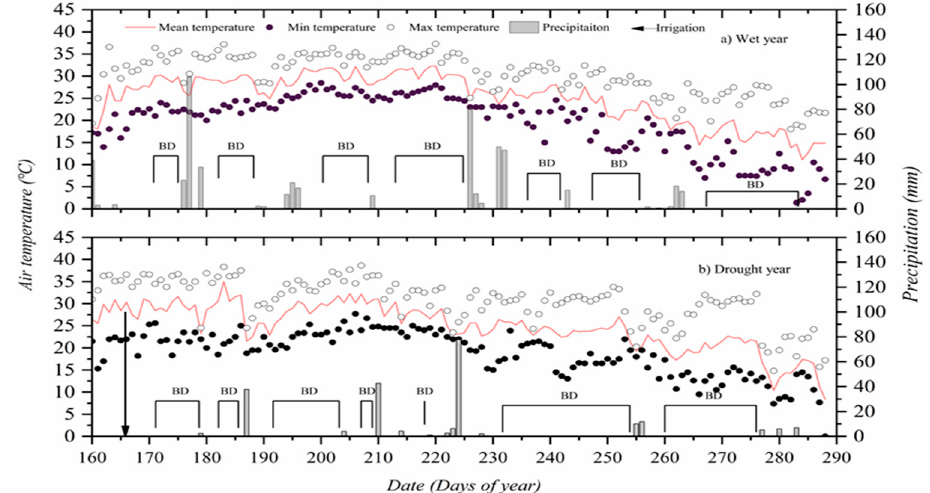
Figure 1. Mean, minimum, and maximum air temperature (°C) and precipitation (mm) during the maize growth stage (day 171–283) ( a : 2018, b : 2019) at the Yucheng experimental station in the North China Plain. BD: bright days [27].